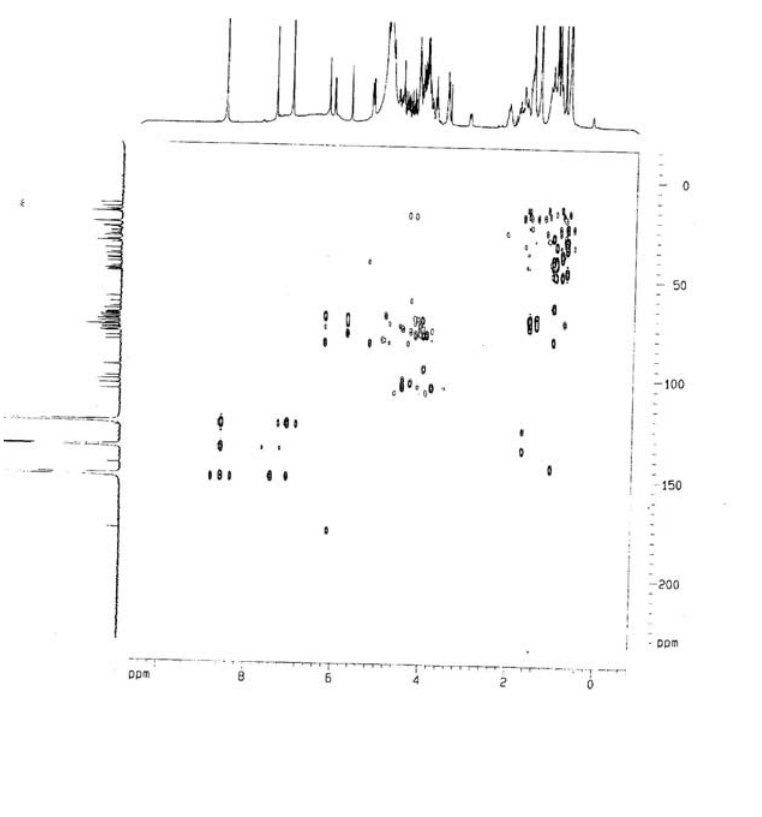
Figure 2. HMBC spectrum of compound 1